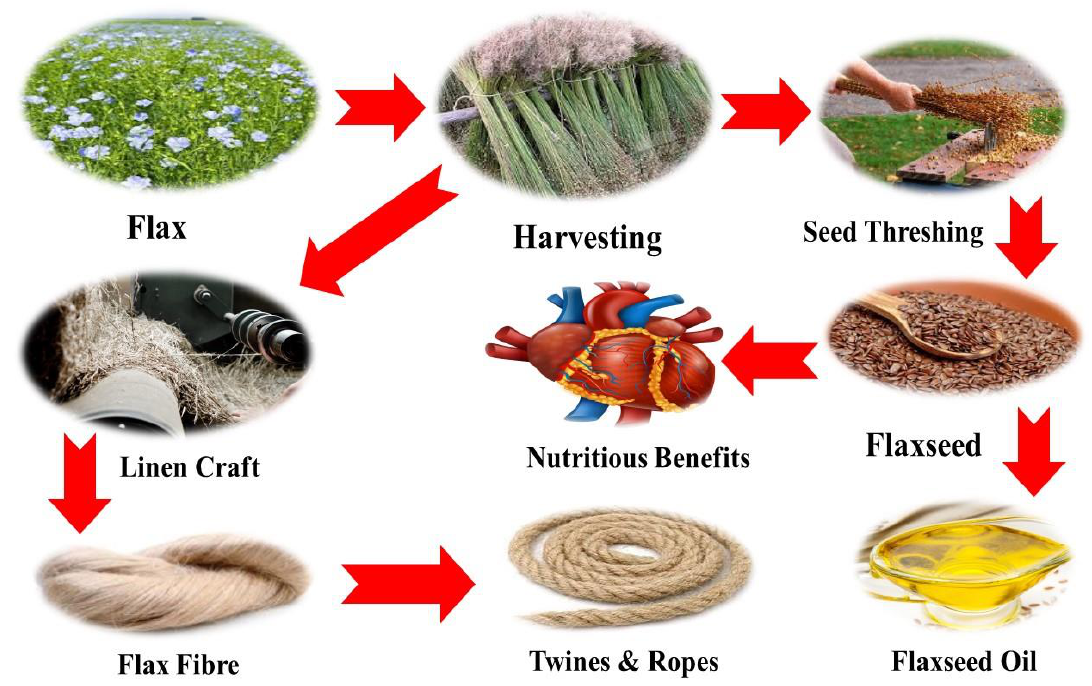
Figure 3. A schematic diagram from the flax field to flax applications.